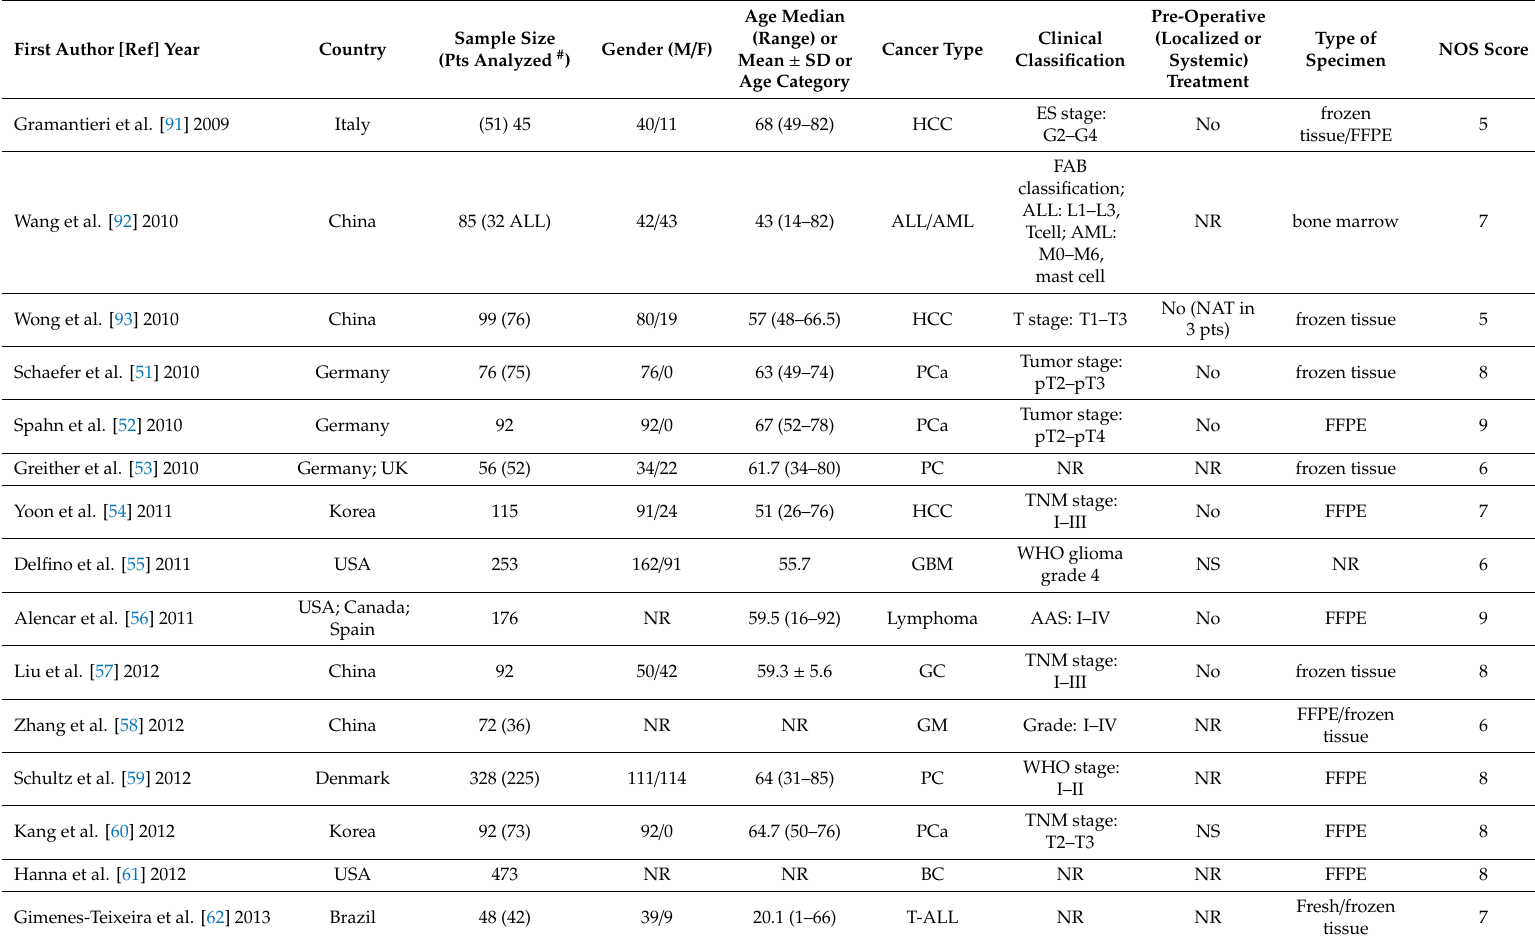
Table 1. Main characteristics of studies evaluating the impact of higher expression of miR-221 or miR-222 on survival outcomes in cancer